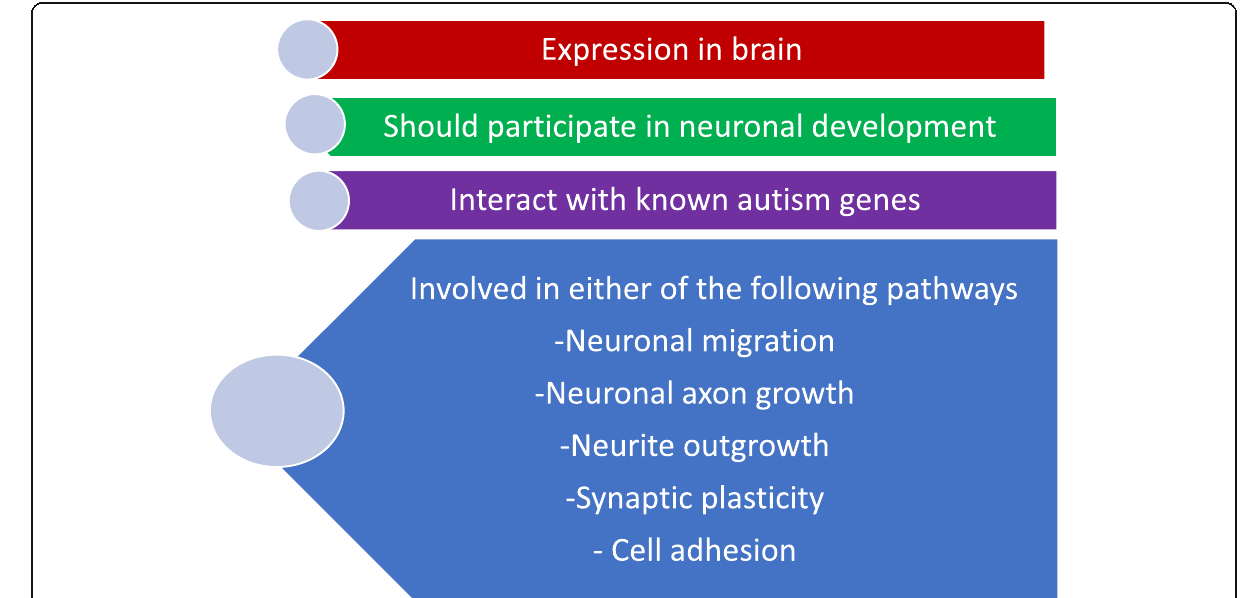
Fig. 1 Inclusion and exclusion criteria for selection of autism genes for downstream analysis with 0.05 as the P